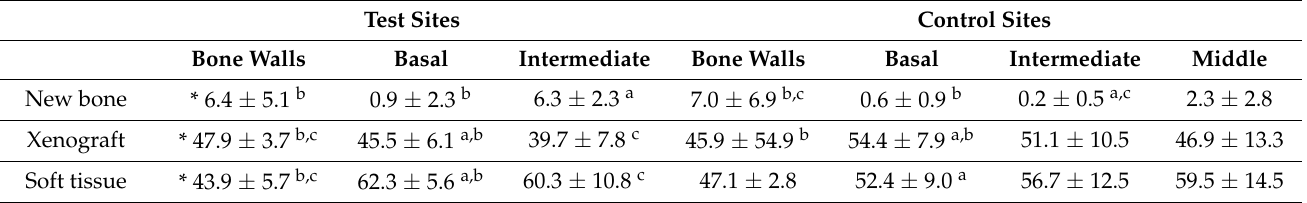
Table 4. Morphometric evaluation of the tissues after 2 weeks of healing in the various regions evaluated. Mean values ± standard deviation in percentages. Test sites with the inward window. Test Sites Control Sites Bone Walls Basal Intermediate Bone Walls